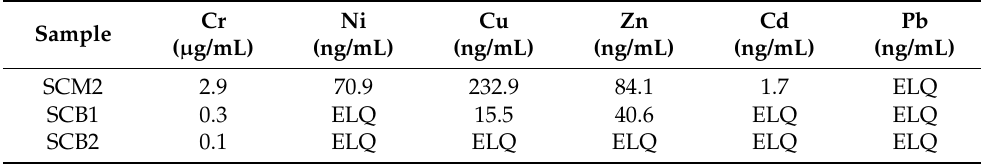
Table 2. Leaching concentration of heavy